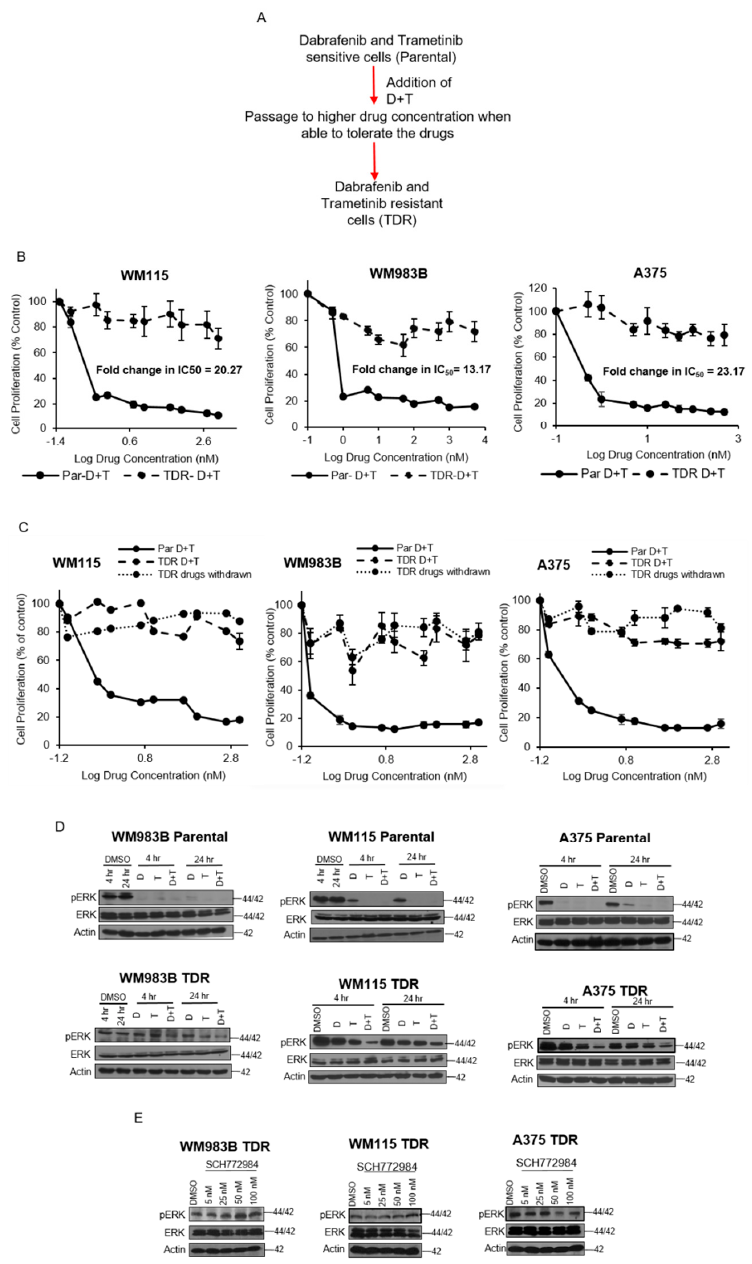
Figure 1. Growth kinetics and characteristics of TDR cell lines. ( A ) Schematic of TDR cell generation. ( B ) WM115, WM983B, and A375 parental and TDR cells (1 × 10 4 cells/well) were seeded in 96-well plates and treated with increasing concentrations of dabrafenib (D) and trametinib (T) (0.1 nM–5 µ M) for 72 h. Cells were treated with MTT for 4 h and absorbance was read at 570 nm. Data reflect three independent experiments and are presented as mean ± SEM. ( C ) Dose response MTT proliferation assay for parental and TDR cell lines maintained in drug ‐ free conditions for 21 days. Cells were plated for 24 h and treated with 72 h with increasing concentrations of dabrafenib (D) and trametinib (T). Cells were treated with MTT. Data reflected as mean ± SEM. ( D ) Immunoblots of WM983B, WM115, and A375 parental and TDR cells treated for 4 and 24 h with dabrafenib (D), trametinib (T), or combination of dabrafenib and trametinib (D + T). Whole cell lysates from the cell lines were analyzed by Western blot using indicated antibodies. Actin served as the loading control. ( E ) Immunoblots for TDR cells treated with increasing concentrations of SCH772984 (5–100 nM) for 24 h. Actin was used as the loading control.